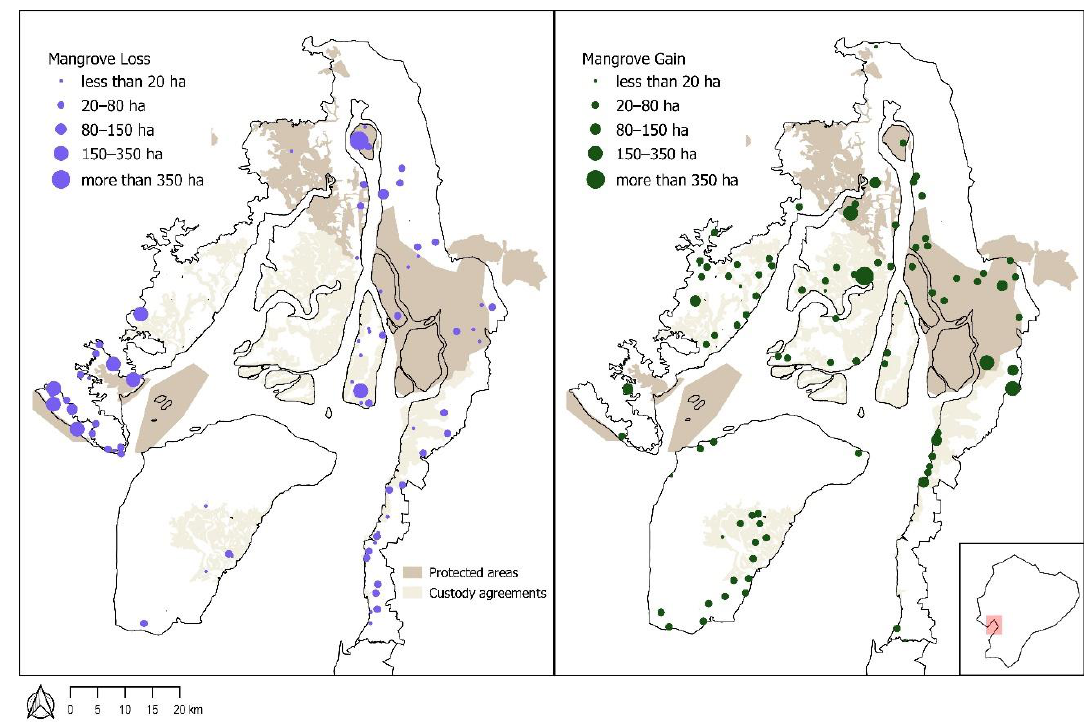
Figure 9. Mangrove losses and gains in the Guayas province between 1984 and 2016.